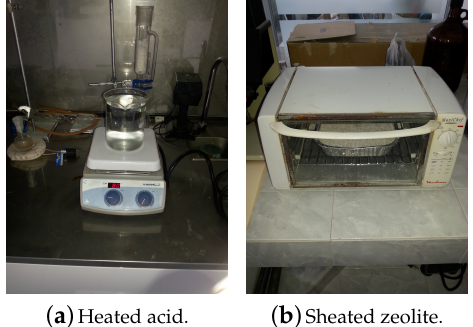
Figure A6. Heated zeolite in the oven and the acid heated on the grill.